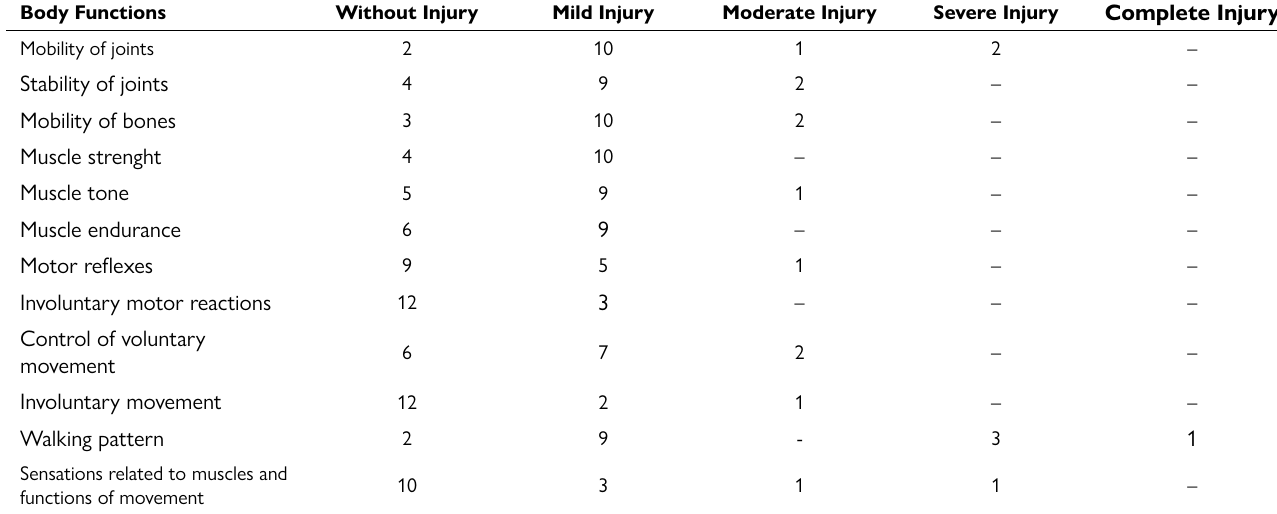
Table 2. Absolute frequency of children and adolescent with MPS in the Body Functions Category according to the ICF (n = 15). Body